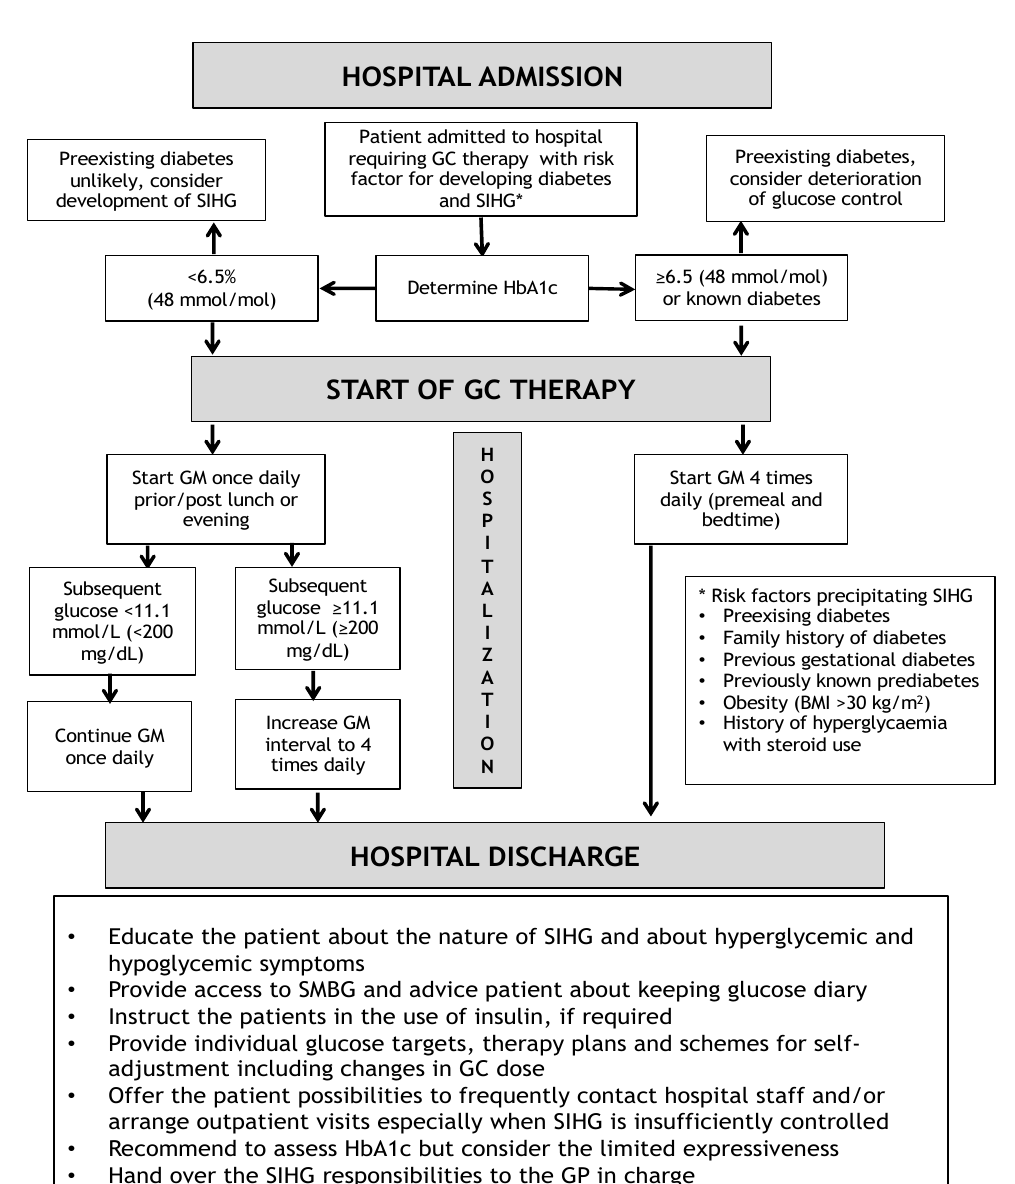
Figure 2. Opinion based admission and discharge algorithm for hospitalized patients with SIHG modified from [33]. BMI = Body mass index, GC = Glucocorticoids, GM = Glucose Monitoring, GP = General practitioner, SIHG = Steroid induced hyperglycaemia, SMBG = self-monitored blood glucose. * = risk factors for steroid induced hyperglycaemia